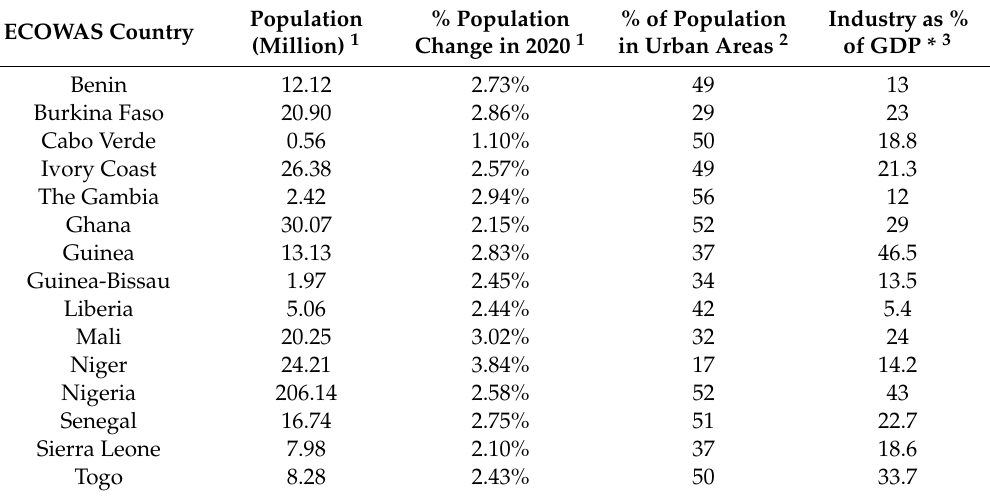
Table 1. Population growth rate and urbanization and industrialization levels of ECOWAS countries. ECOWAS